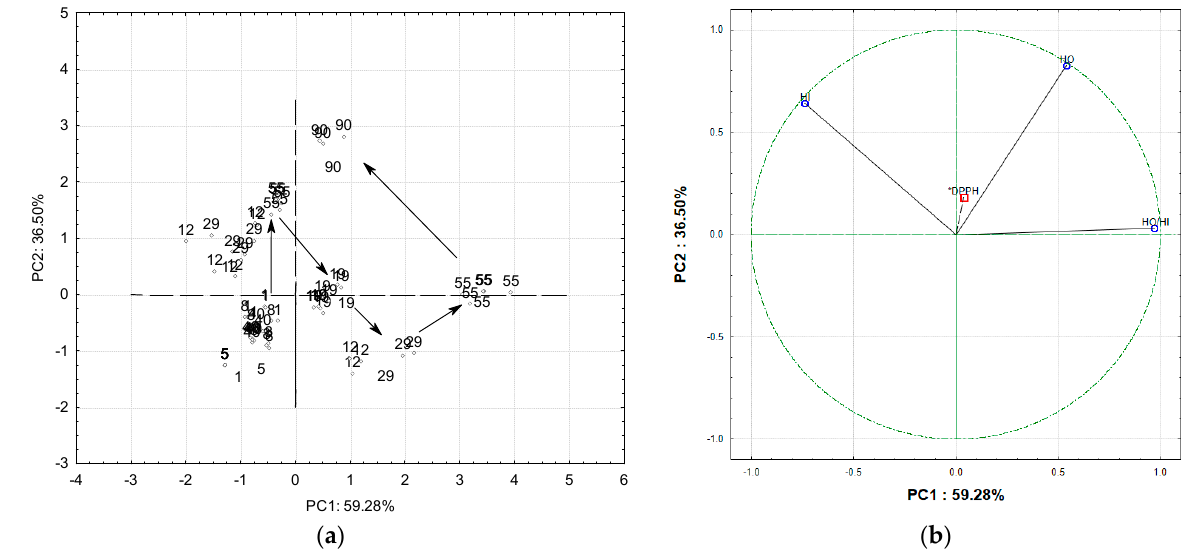
Figure 5. HI, HO, ratio HO/HI, and antioxidant activity in NPN profile. Two principal components (PC1 and PC2) are observed in PCA plots. ( a ) Factorial map obtained by principal components analyses (PCA) all in samples obtained by controlled ripening system. Arrows show the trend followed throughout the ripening process. ( b ) Factor loading plots (PC1 and PC2). Samples code represents the ripening day.